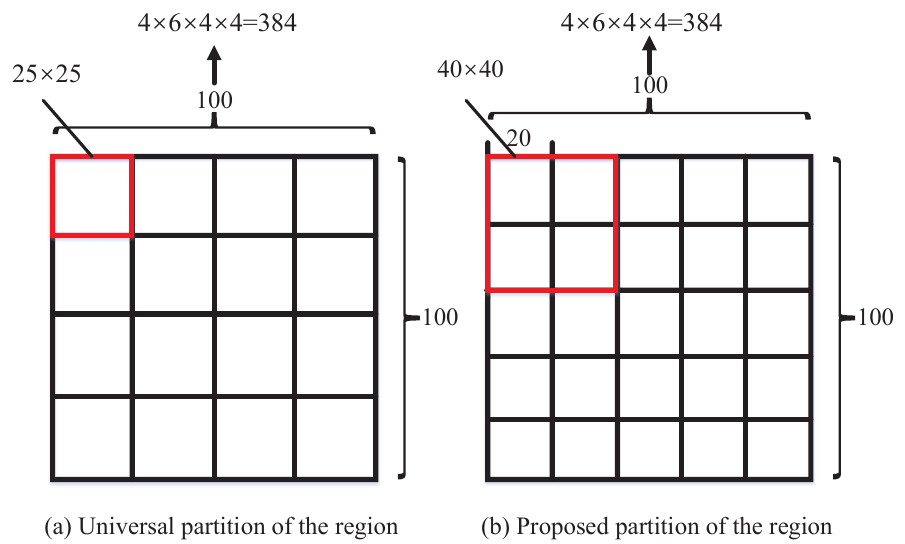
Figure 5. Partition of the neighborhood of a certain pixel.